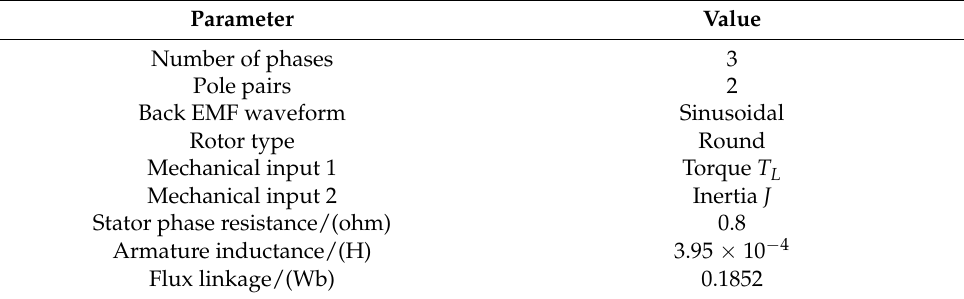
Table 2. Parameter settings of the PMSM